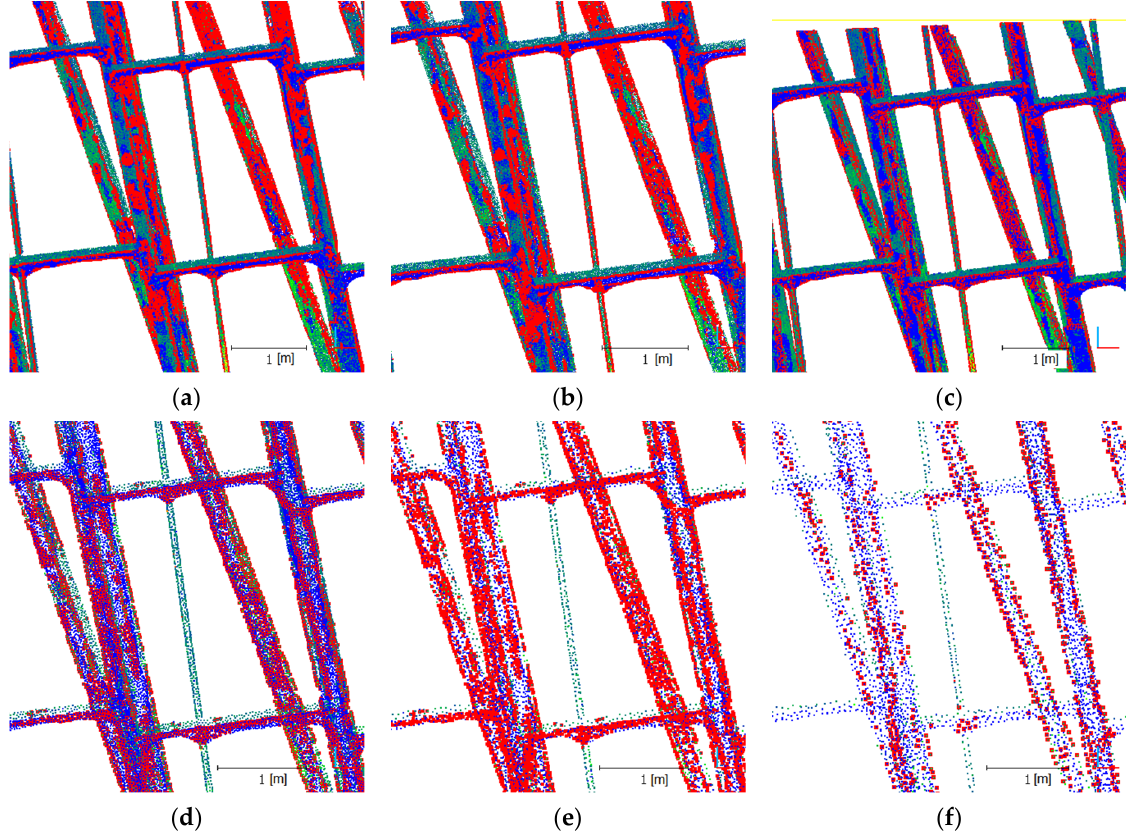
Figure 15. Structure extraction results by the source of the point origin: ( a ) no reduction, ( b ) 0.5 mm, ( c ) 1 mm, ( d ) 3 mm, ( e ) 5 mm, ( f ) 7 mm (green: TLS points; blue: UAV points; red: edges detected).